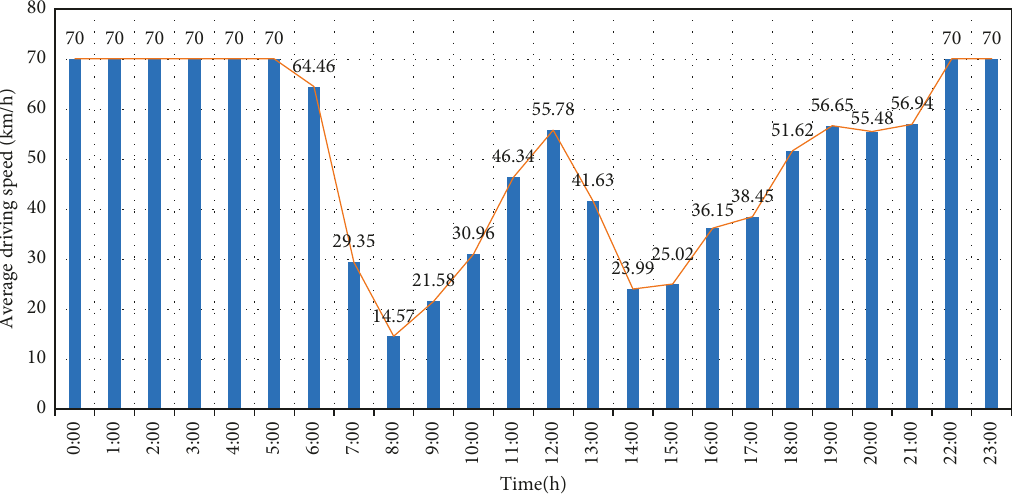
Figure 1: Speed distribution of EVs used in the